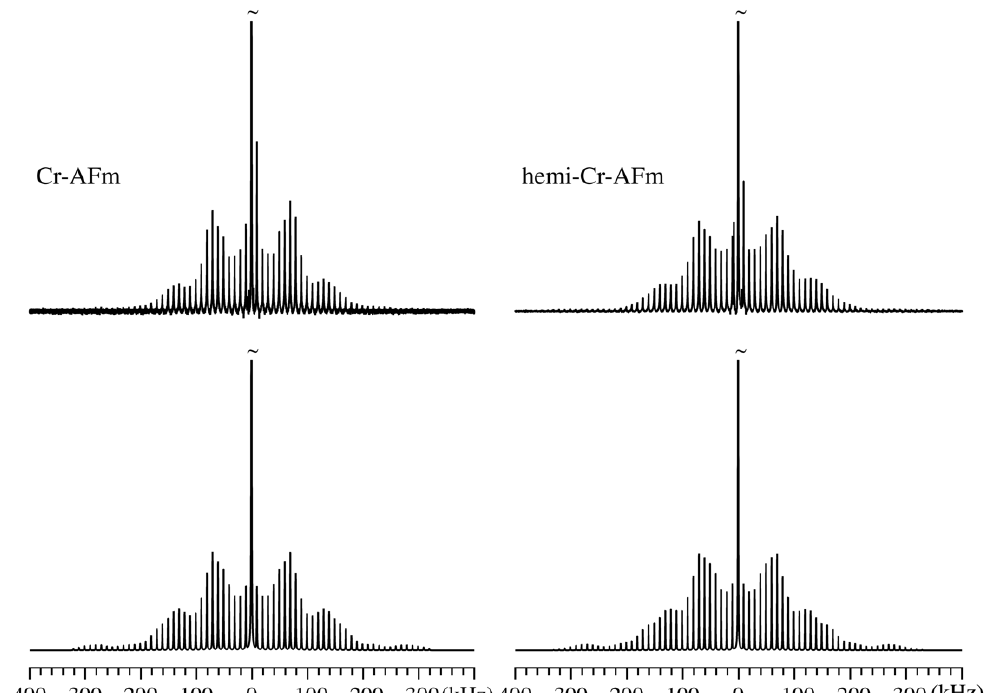
Figure 4. Experimental (upper row) and simulated (lower row) 27 Al MAS NMR spectra of the central and satellite transitions for monochromate and hemichromate acquired at 9.4 T using a spinning speed of ν R = 10 kHz. The centre band from the central transition is cut-off at approx. 1/20 of its total height in all spectra.